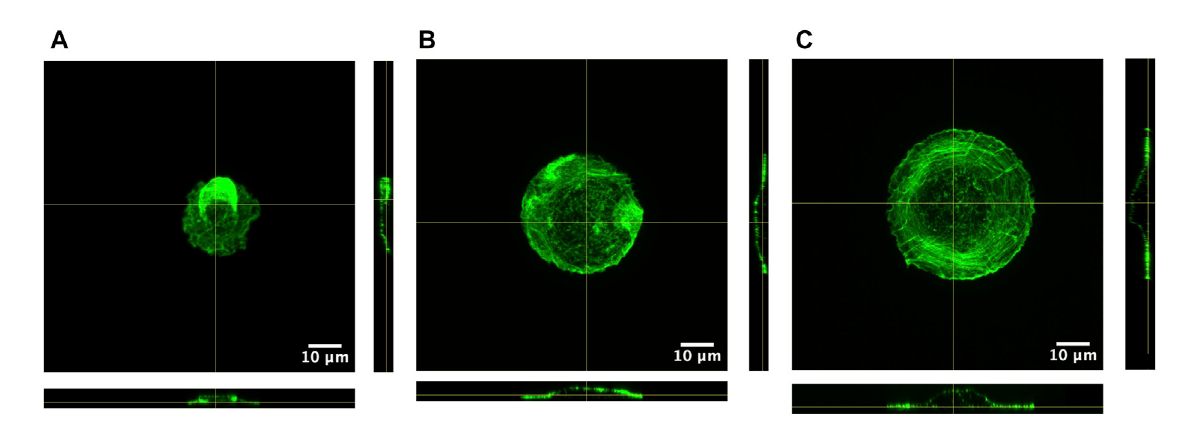
FIGURE 3 Z and orthogonal projections of scar fi broblasts patterned in (A) 25-µm circle, (B) 35-µm circle, and (C) 45-µm circle. Actin fi bers labeled in green. (Supplementary Figures S11, S12: control and Dupuytren fi broblasts